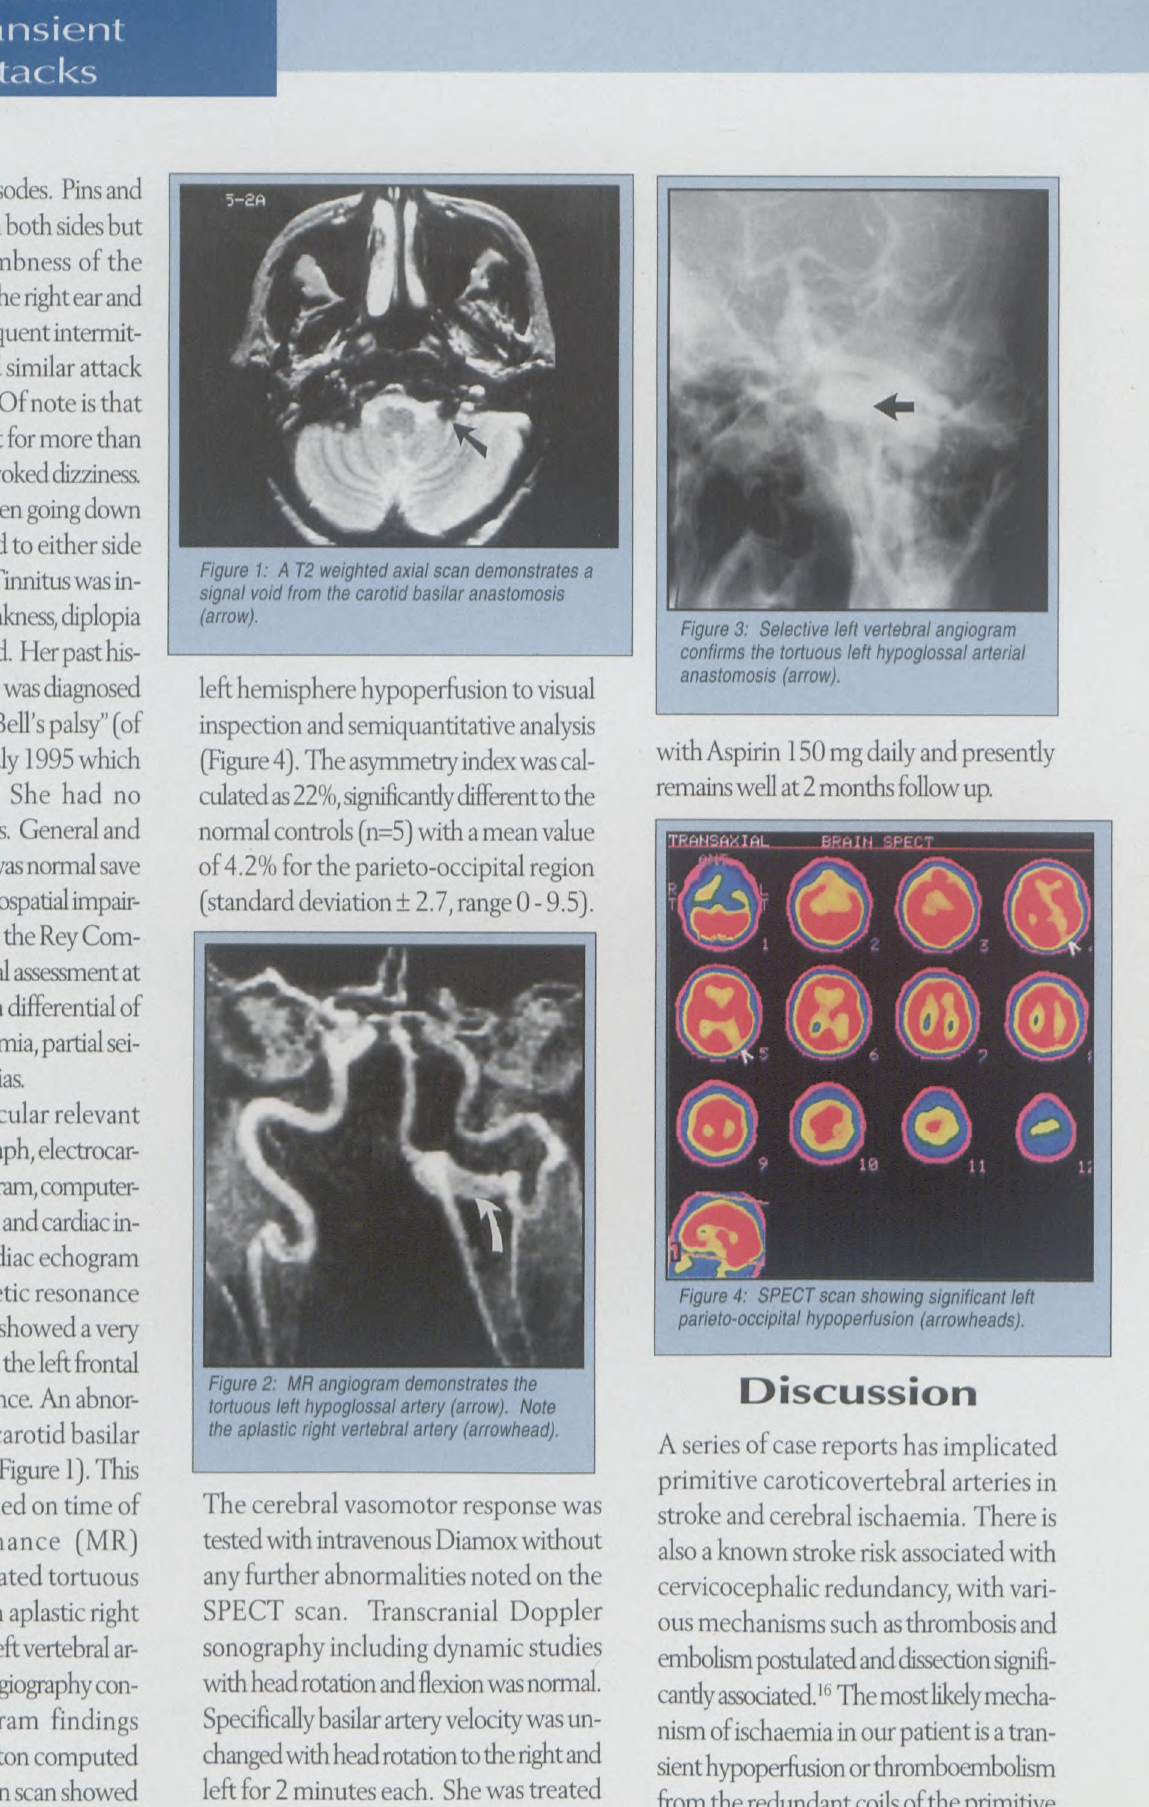
Figure 2: MR angiogram demonstrates the tortuous left hypoglossal artery (arrow). Note the aplastic right vertebral artery (arrowhead).